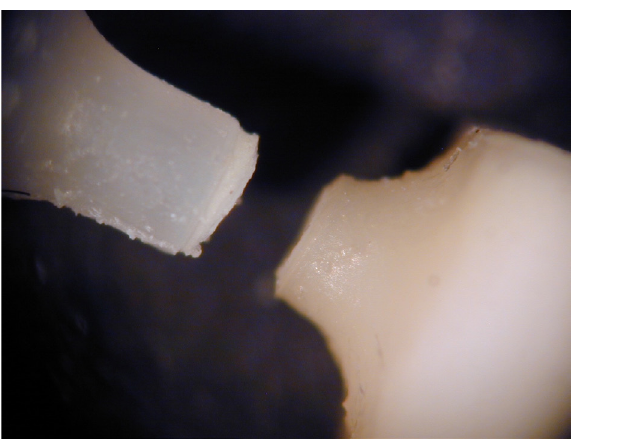
Figure 2- Weibull plot of probability of failure (%) against the microtensile bond strength (TBS) at failure for each of the storage conditions (d - days, mo – months, MPa – megapascal)